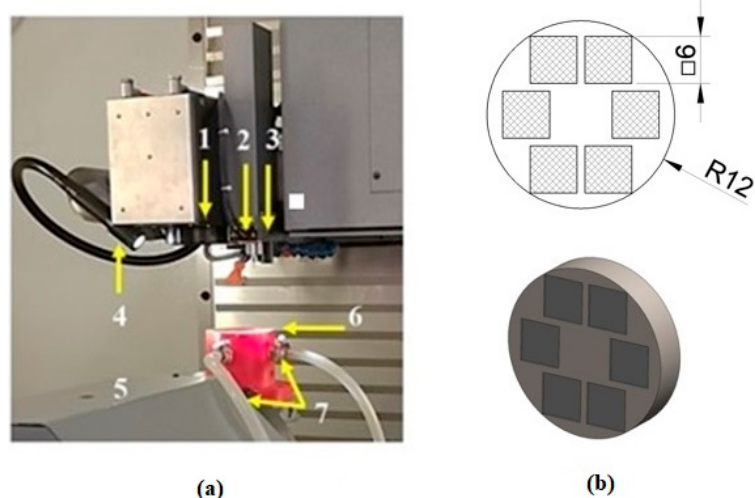
Figure 2. Experimental setup: ( a ): experimental workplace; ( b ): sample with 6 experimental surfaces 1–beam guidance with scanner, 2–Z-level measuring probe, 3–positioning and measuring CCD camera, 4–lighting, 5–kinematics of working table, 6–fixture, 7–shielding gas inlet.